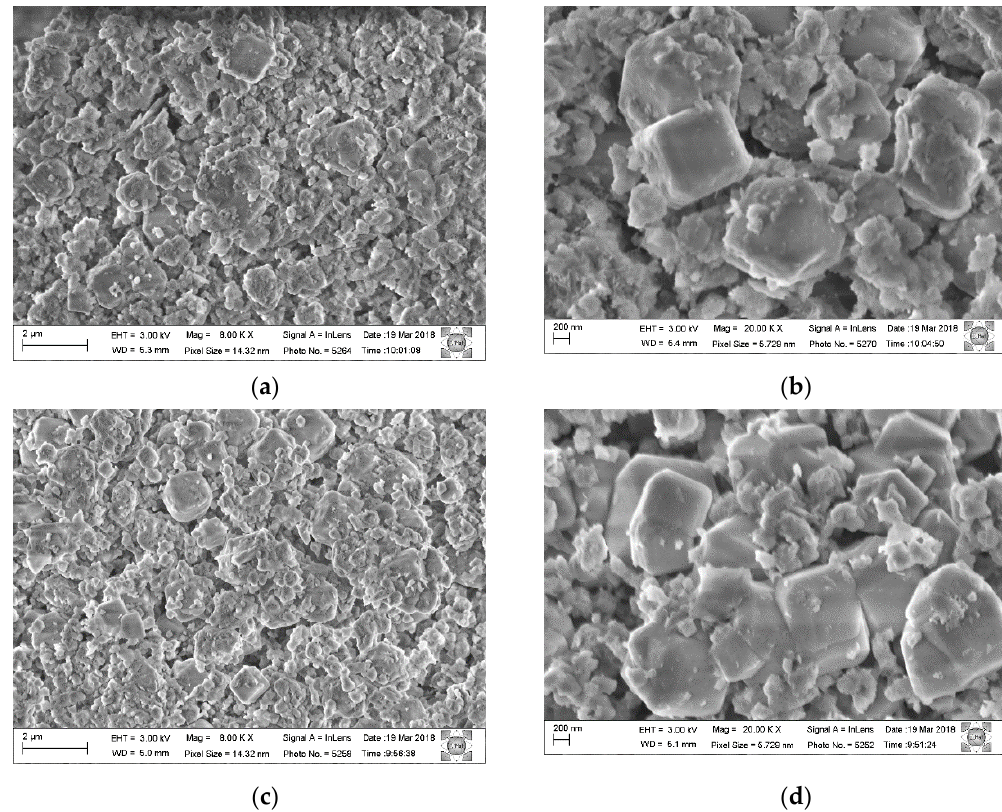
Figure 11. Micrographs of the calcined and rehydrated physical mixture: ( a , b ) under He flow and heated to 300 ◦ C, with different magnifications. Micrographs ( c , d ) under the flow of O 2 at 500 ◦ C, with different magnifications.